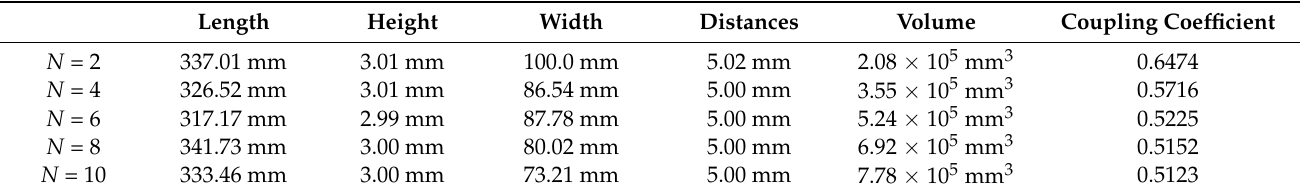
Table 5. Results of the optimization.